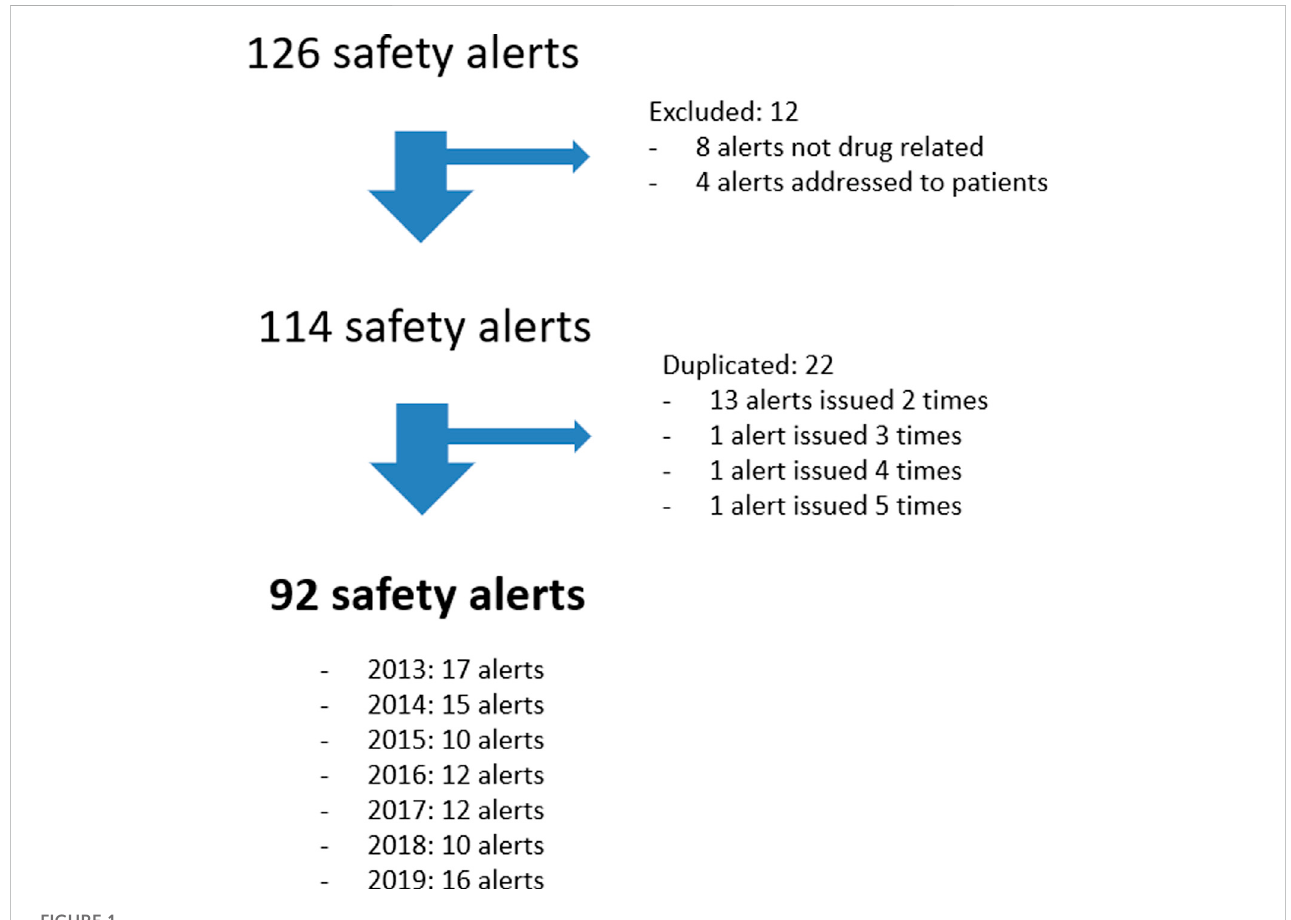
FIGURE 1 Flow chart of included safety